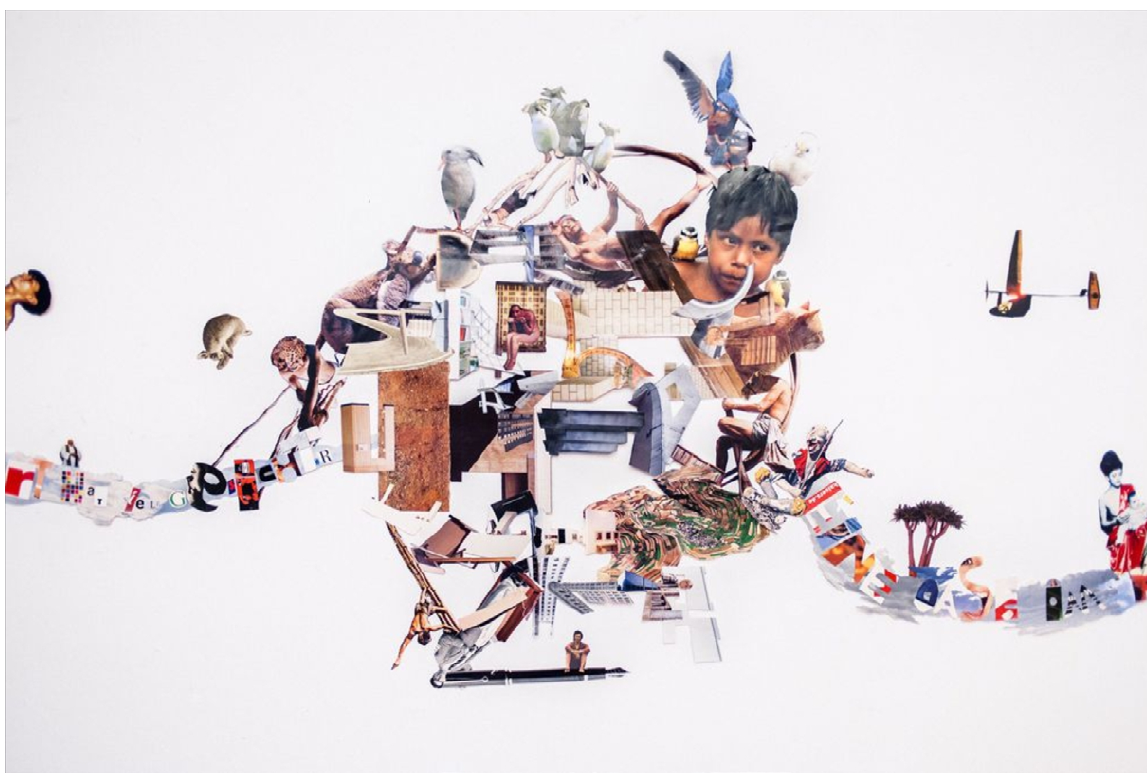
Exhibition at Kotti-Shop for “We decide how we reside,” October 2015, © David